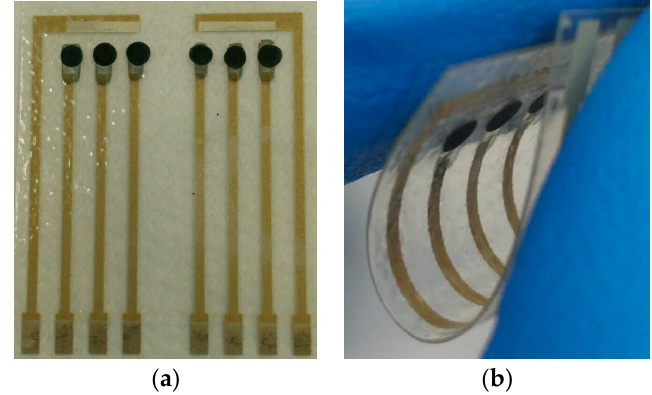
Figure 2. The photos of flexible arrayed lactate biosensor under ( a ) unfolded state and ( b ) bended state.